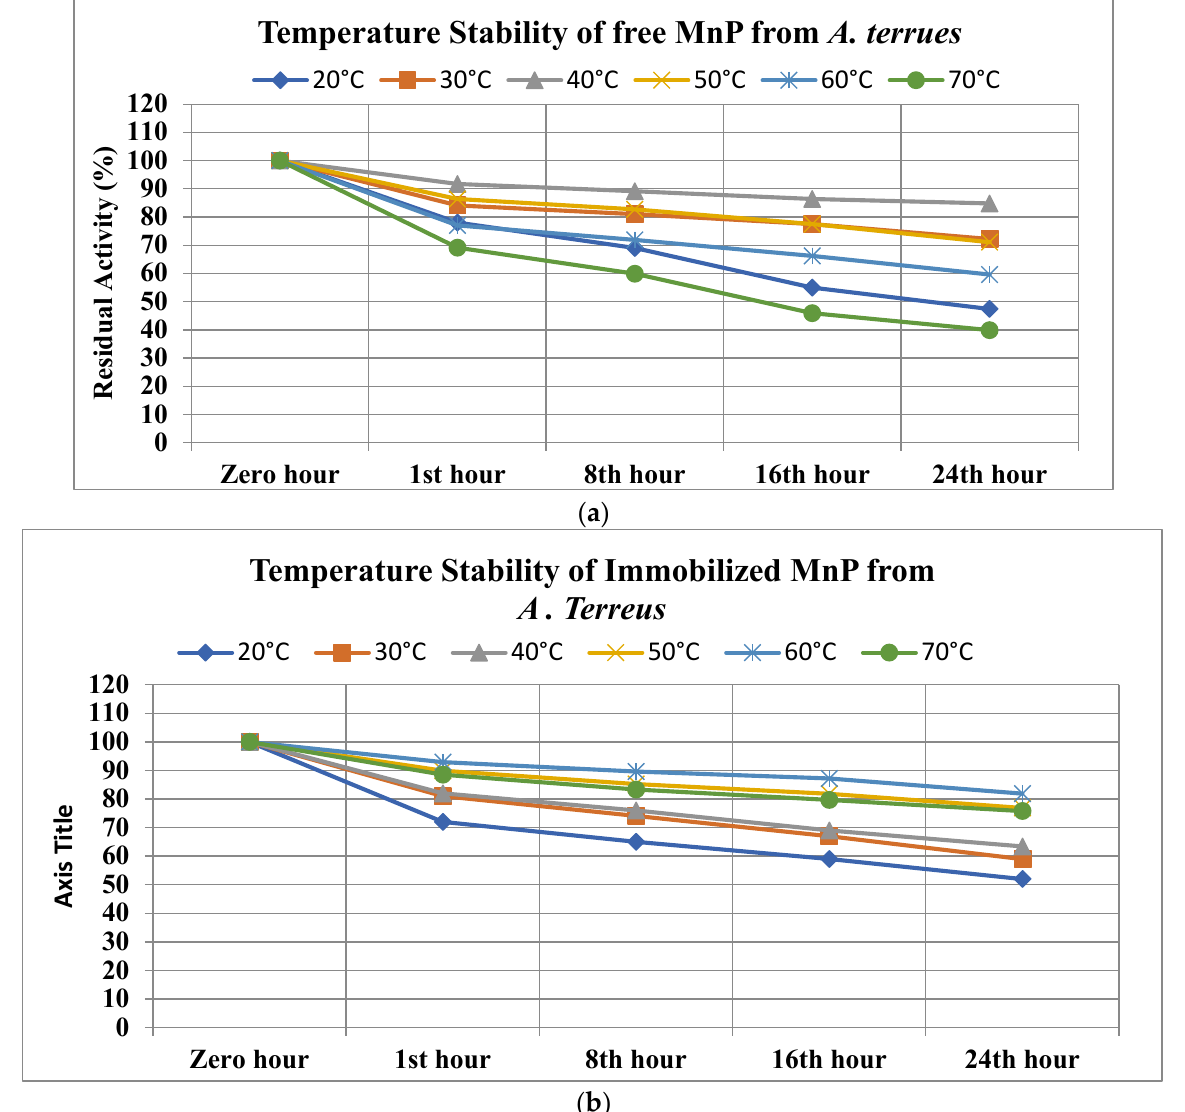
Figure 9. ( a ) Temperature stability of free MnP from A. terreus. ( b ) Temperature stability of immobilized MnP from A. Terreus.